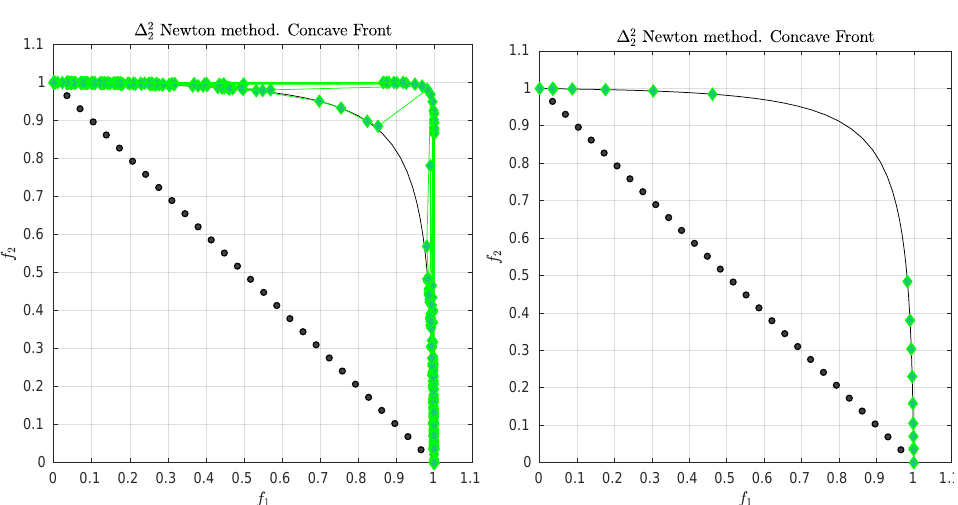
Figure 12. ( Left ) application of the ∆ 2